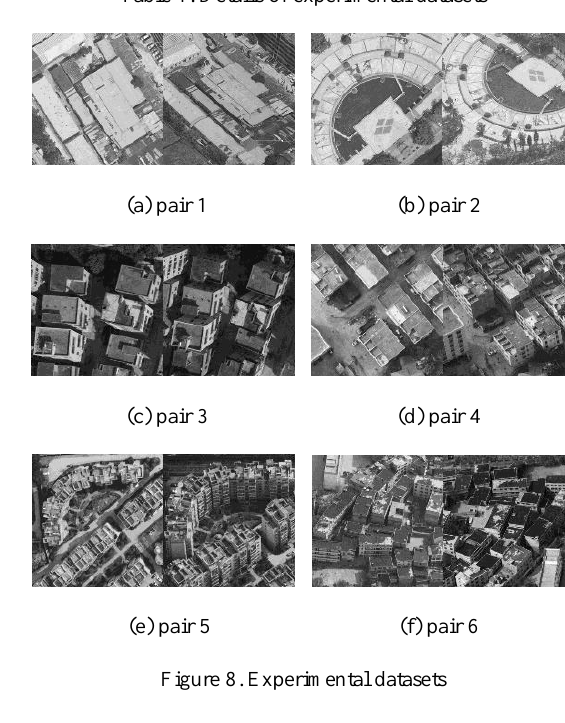
Table 1. Details of experimental datasets